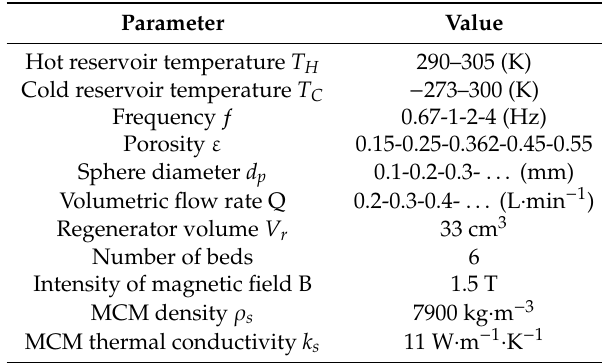
Table 3. Modeling